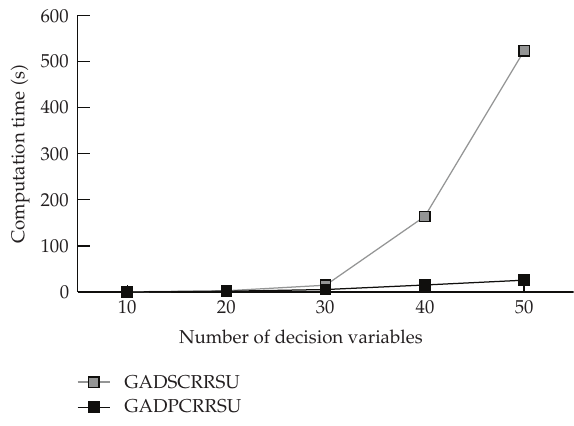
Figure 9: The comparison of computation